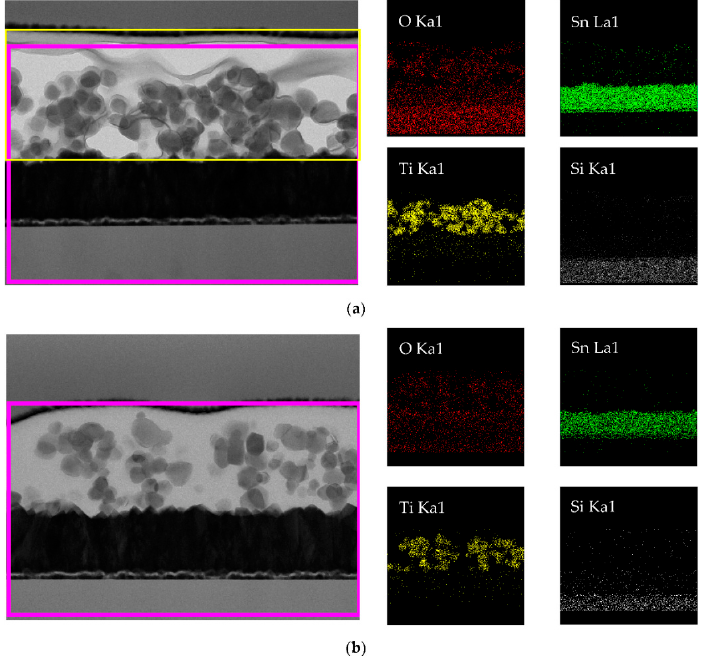
Figure 11. The energy-dispersive X-ray spectroscopy images of element distribution for the 350 °C-annealed TiO 2 film prepared ( a ) without and ( b ) with the 7.5 wt% DMF dose. Table 3. The concentration of the carbon and nitrogen of the 350 °C-annealed samples with and without the 7.5 wt% DMF dose. Sample Carbon Nitrogen Oxygen